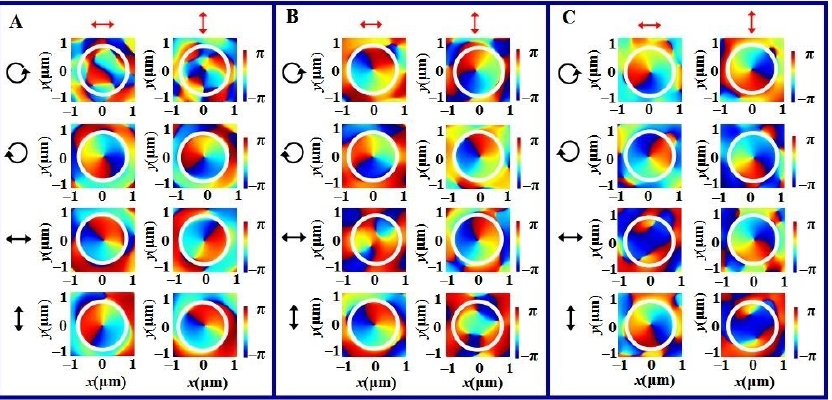
Figure 4. Transverse phase distributions of three vortex metalenses at the focal plane under different polarized light illumination, where ( A ) refers to the geometric phase vortex metalens, ( B ) is for the propagation phase vortex metalens and ( C ) corresponds to the resonant phase vortex metalens. The inserted black arrows on the left of patterns denote the incident polarization states and the red arrows on the top denote the detection direction of the polarization analyzer. The circles inserted in the patterns are convenient for the